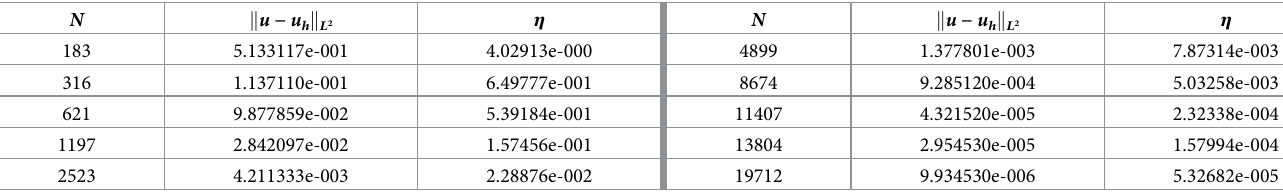
k and error indicator η of the L-shape mesh for experiment h L 2